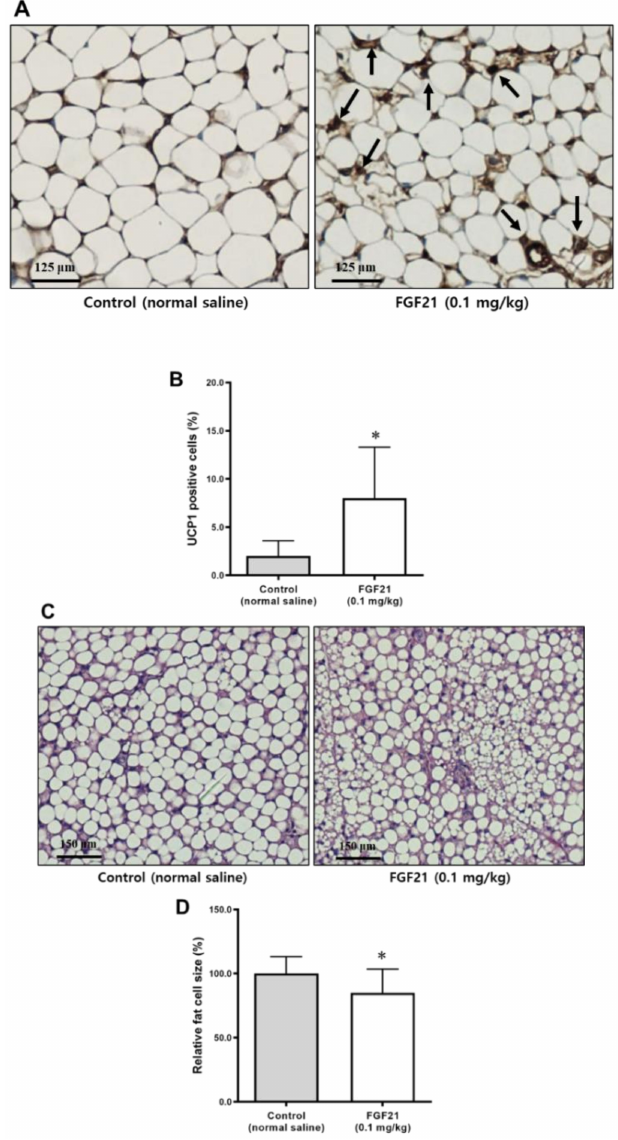
Figure 6. ( A ) Histology of abdominal subcutaneous adipose tissues stained with H&E (scale bars, 20 µ m). Arrows indicate uncoupling protein 1 (UCP1)-positive cells. ( B ) UCP1-positive cells were significantly more abundant in the FGF21-treated mice than in the control (% of total cells). ( C ) Histology of brown adipose tissues stained by H&E (scale bars, 20 µ m). ( D ) Comparison of fat cell size (% of control) between the control and the FGF21 group. Data are means ± SD. * p < 0.05 vs.